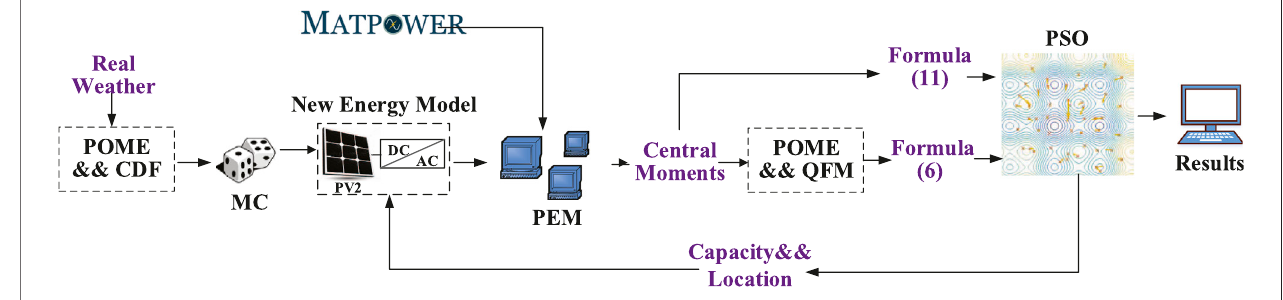
FIGURE 2 | Schematic diagram of the proposed methodology.